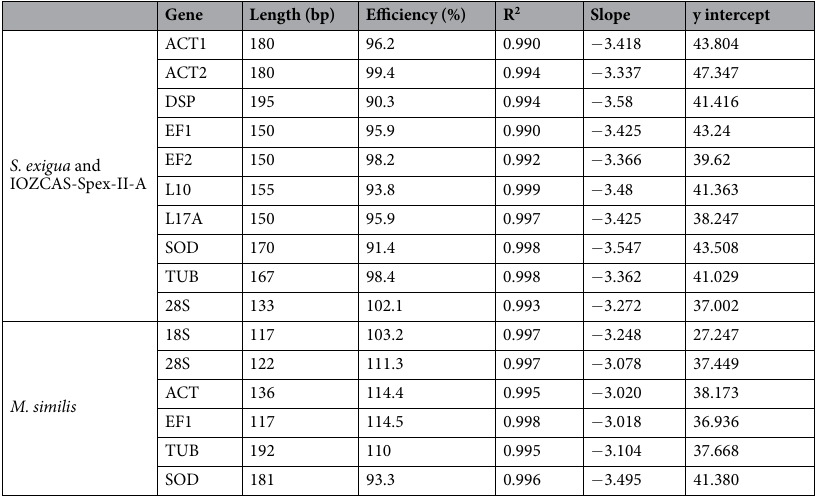
Table 1. PCR amplification efficiency of candidate reference